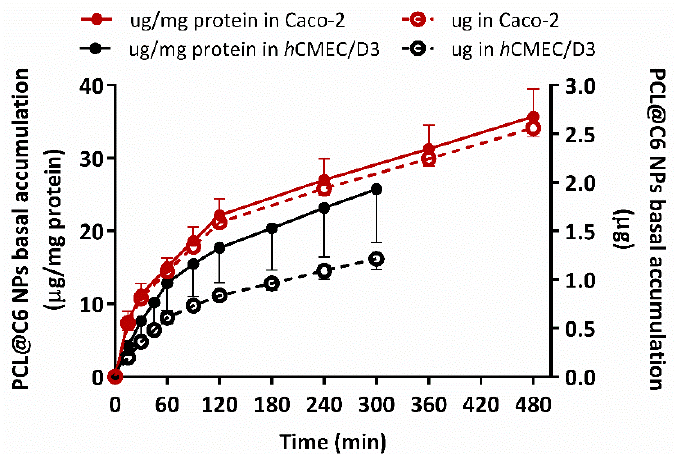
Figure 8. Amount of PCL@C6 NPs, with ( µ g / mg of protein, solid circles and line) or without ( µ g, empty circles points and dash line) protein mass normalization, accumulated in basal medium after 5 h and 8 h of permeability experiment in h CMEC / D3 (black data) and Caco-2 (red data) cells with a 100 µ g / mL initial concentration. Results are expressed as mean ± SD of three independent experiments.